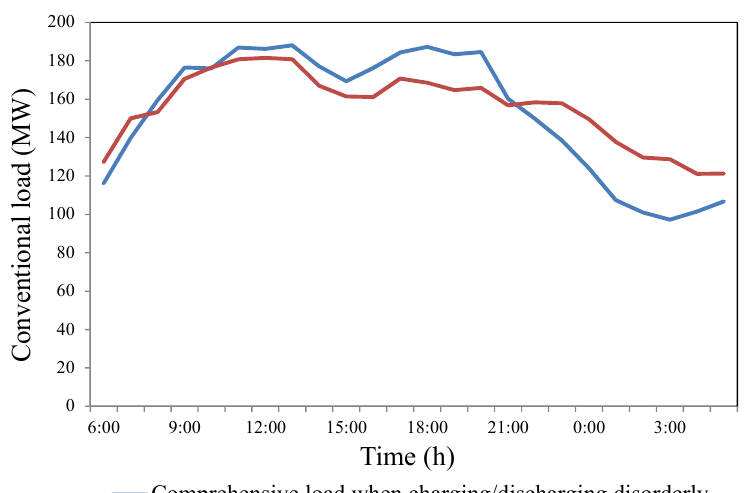
Figure 6. Change of comprehensive